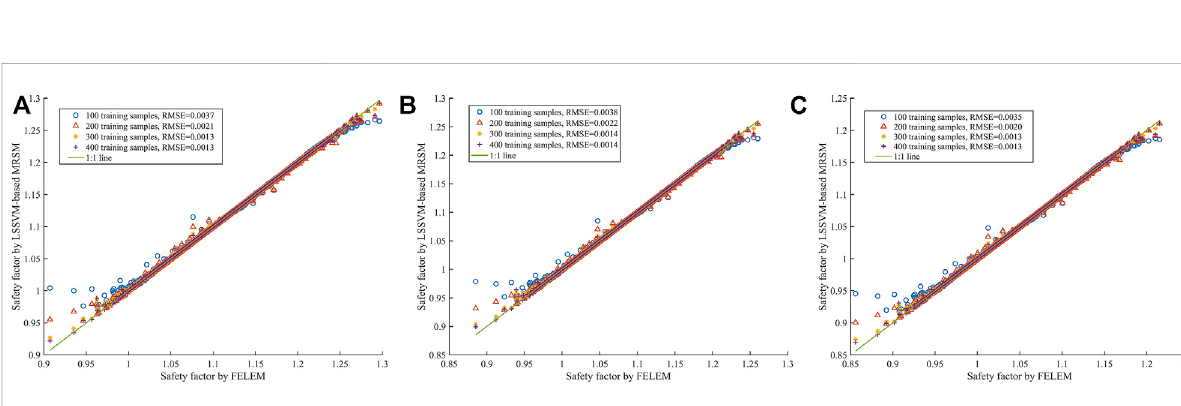
FIGURE 12 Comparison of safety factor predicted by LSSVM-based MRSM with the four training sample sizes. (A) 1st sliding surface (B) 2nd sliding surface (C) 3rd sliding